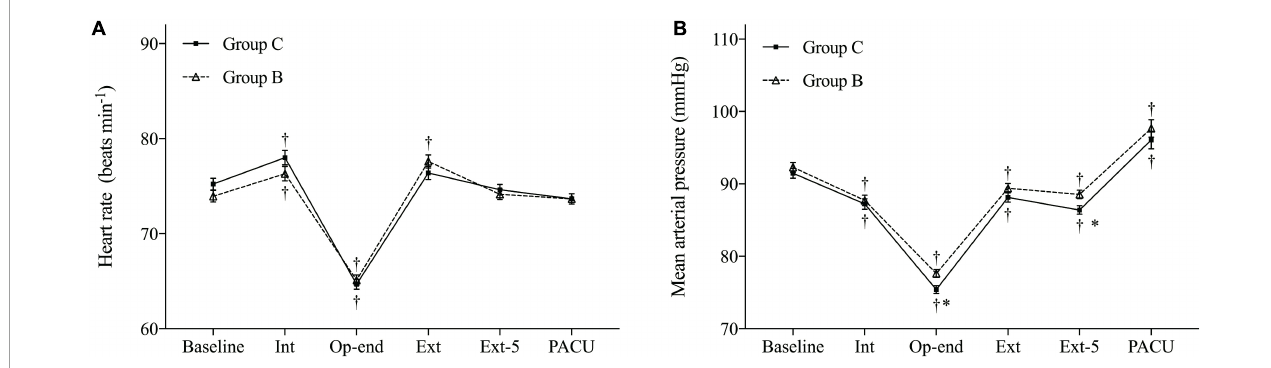
FIGURE3 Hemodynamic changes during the operation and emergence. (A) Heart rate (HR) and (B) mean arterial pressure (MAP). Baseline, before anesthesia induction; Int, intubation; Op-end, end of operation; Ext, extubation; Ext-5, 5 min after extubation; PACU, before leaving PACU. Data are expressed as mean (SD). ∗ P < 0.05 compared with Group C (Bonferroni corrected). † P < 0.05 compared with baseline in each group (Bonferroni corrected).